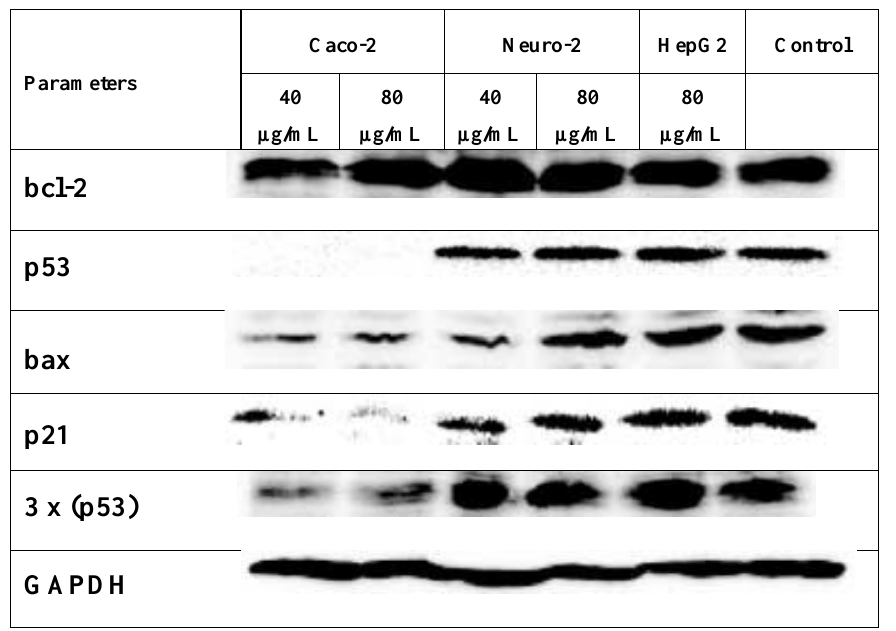
Table 8. Expression of genes involved in cell cycle and cell death in the presence of PHMB in Caco-2, Neuro-2A and HepG2 cells, as determined by RT-PCR. Because Caco-2 cells do not have a functional p53 gene, a second quantitative assay was run in which 3 times the amount of DNA was loaded on the gel. Gene expression in HepG2 cells was investigated only at 80 µg/mL PHMB. Caco-2 Neuro-2 HepG2 Control Parameters 40 80 40 80 80 µg/mL µg/mL µg/mL µg/mL µg/mL